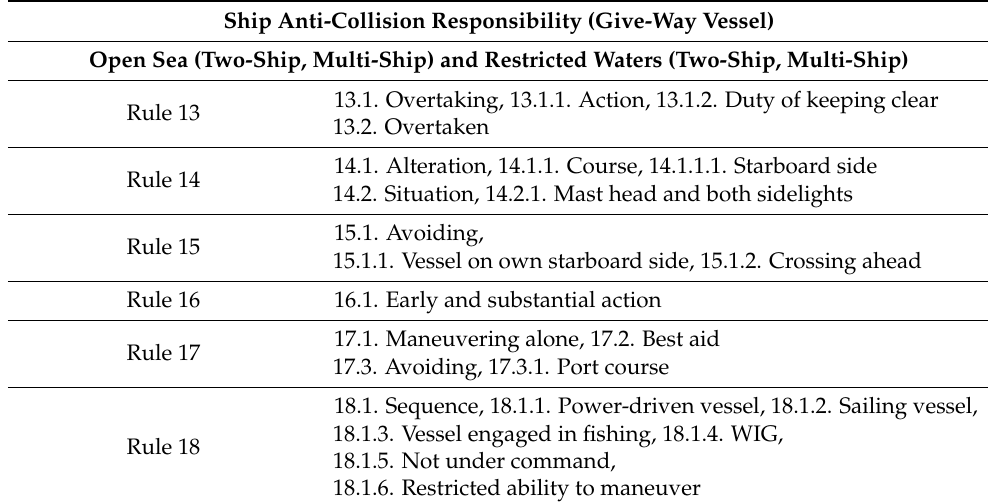
Table 3. Requirements analysis for ship anti-collision responsibility (give-way vessel).